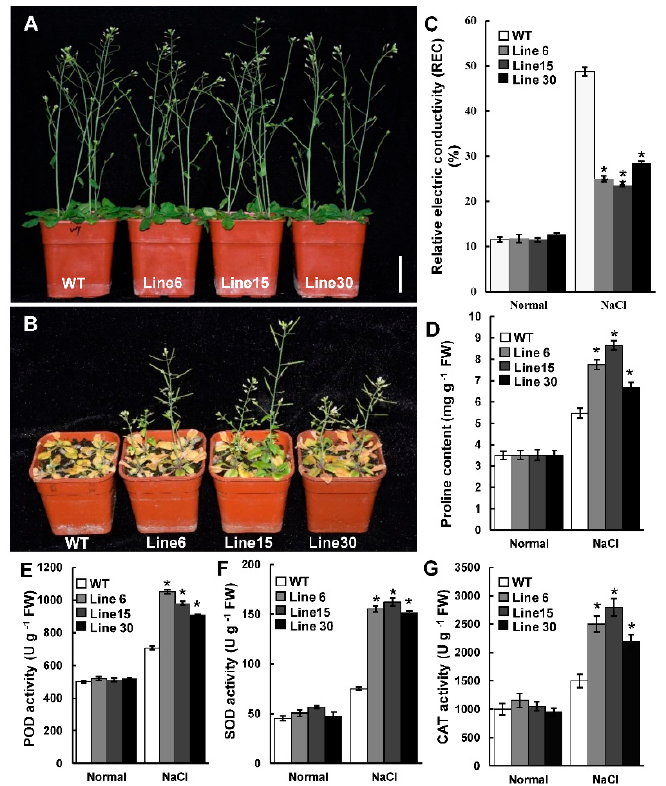
Figure 5. Salt stress tolerance analysis in soil growth condition. ( A , B ) Photograph of WT and transgenic seedlings under normal condition ( A ) and salt treatment ( B ). ( C – G ) Measurement of the Relative electric conductivity (REC) ( C ), proline content ( D ), POD activity ( E ), SOD activity ( F ), and CAT activity ( G ). Error bars indicate the standard deviations, and * indicates significant differences compared with WT at the p < 0.05 level.